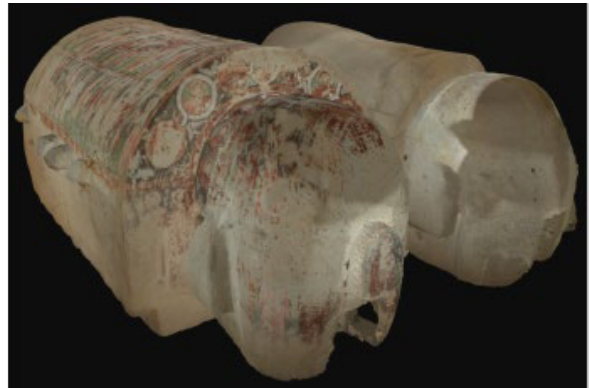
Figure 5. Wall-painting after virtual toning However, depicting brush strokes or gradations of the colors,